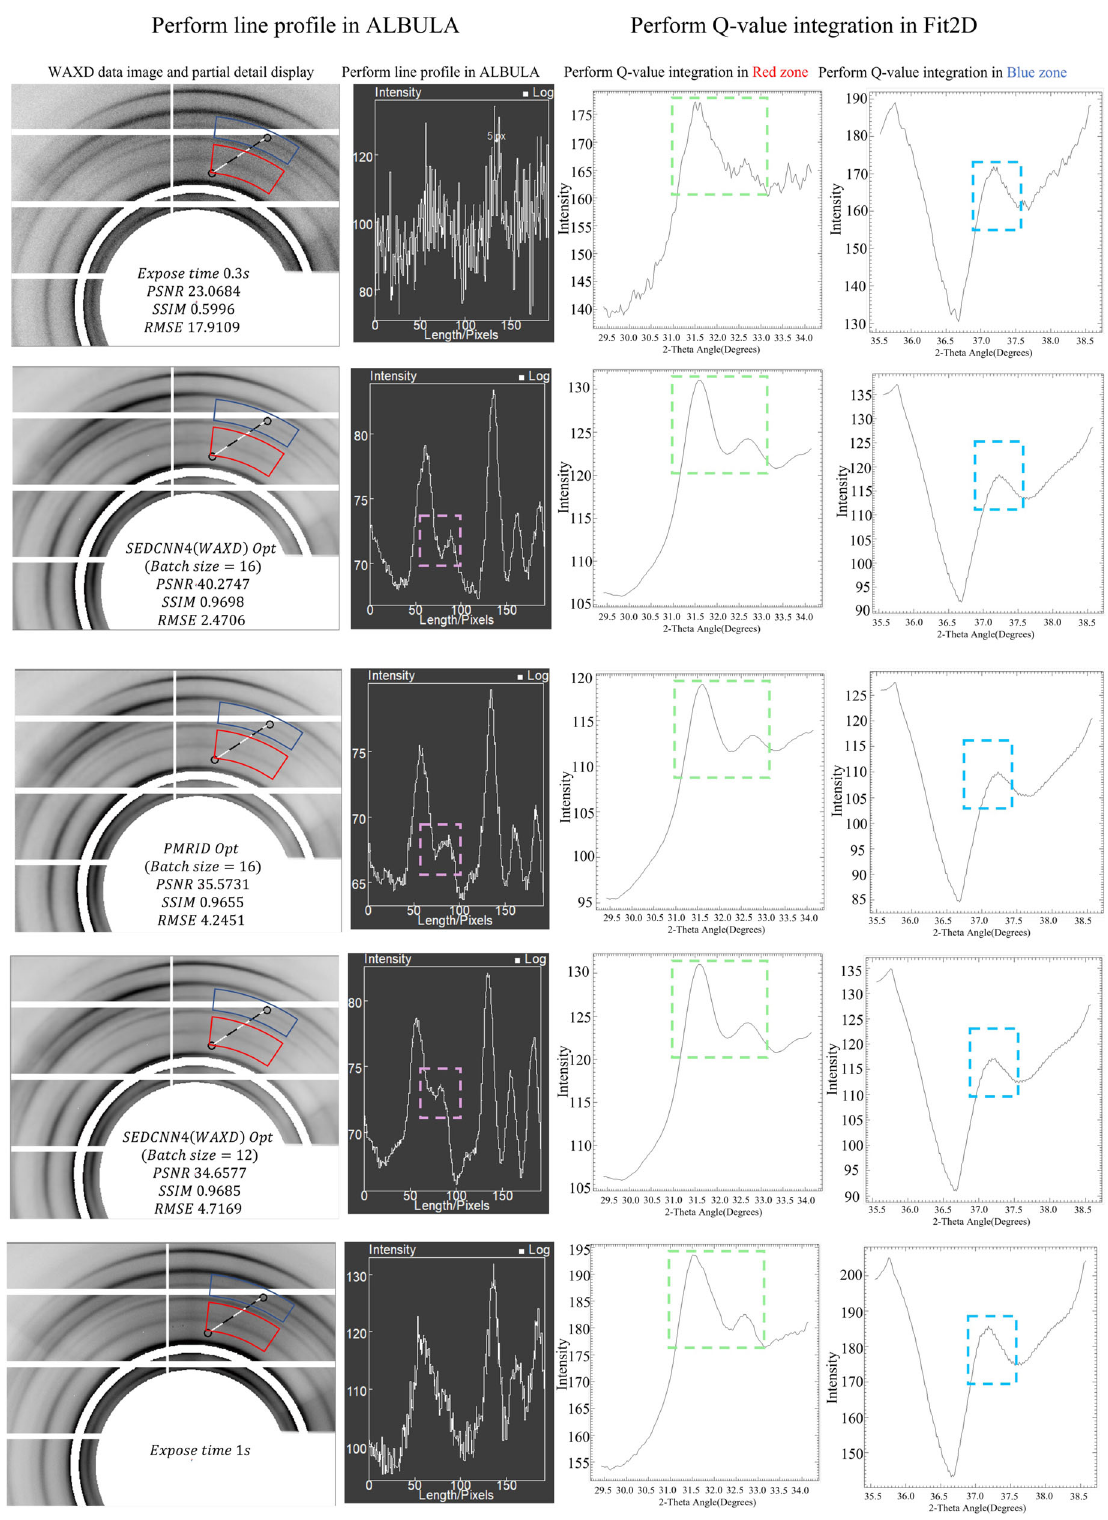
Fig. 9 Line pro fi le and Q -value integration visually compare the denoising effect on experimental WAXD images using our SEDCNN (WAXD, batch size equaling 12 and 16) and PMRID. Compared to Fig. 5, results of PMRID and SEDCNN4 with batch size 12 were added. Similar evaluation method used in Fig. 5 was also applied